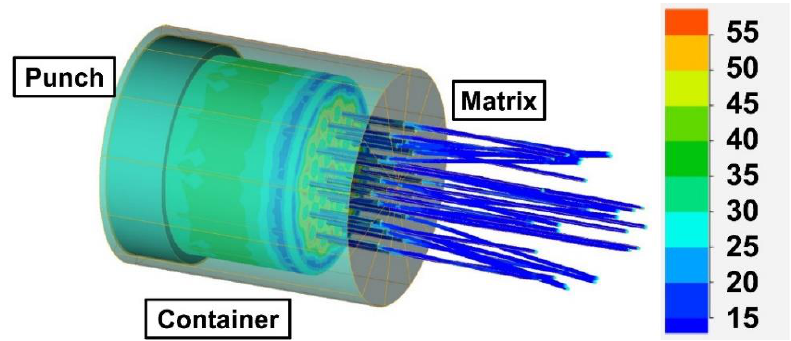
Figure 3. A three-dimensional model of the extrusion and flow stress distribution for the extrusion velocity of 0.25 mm/s and initial temperature of workpiece and matrix of 400 °С.